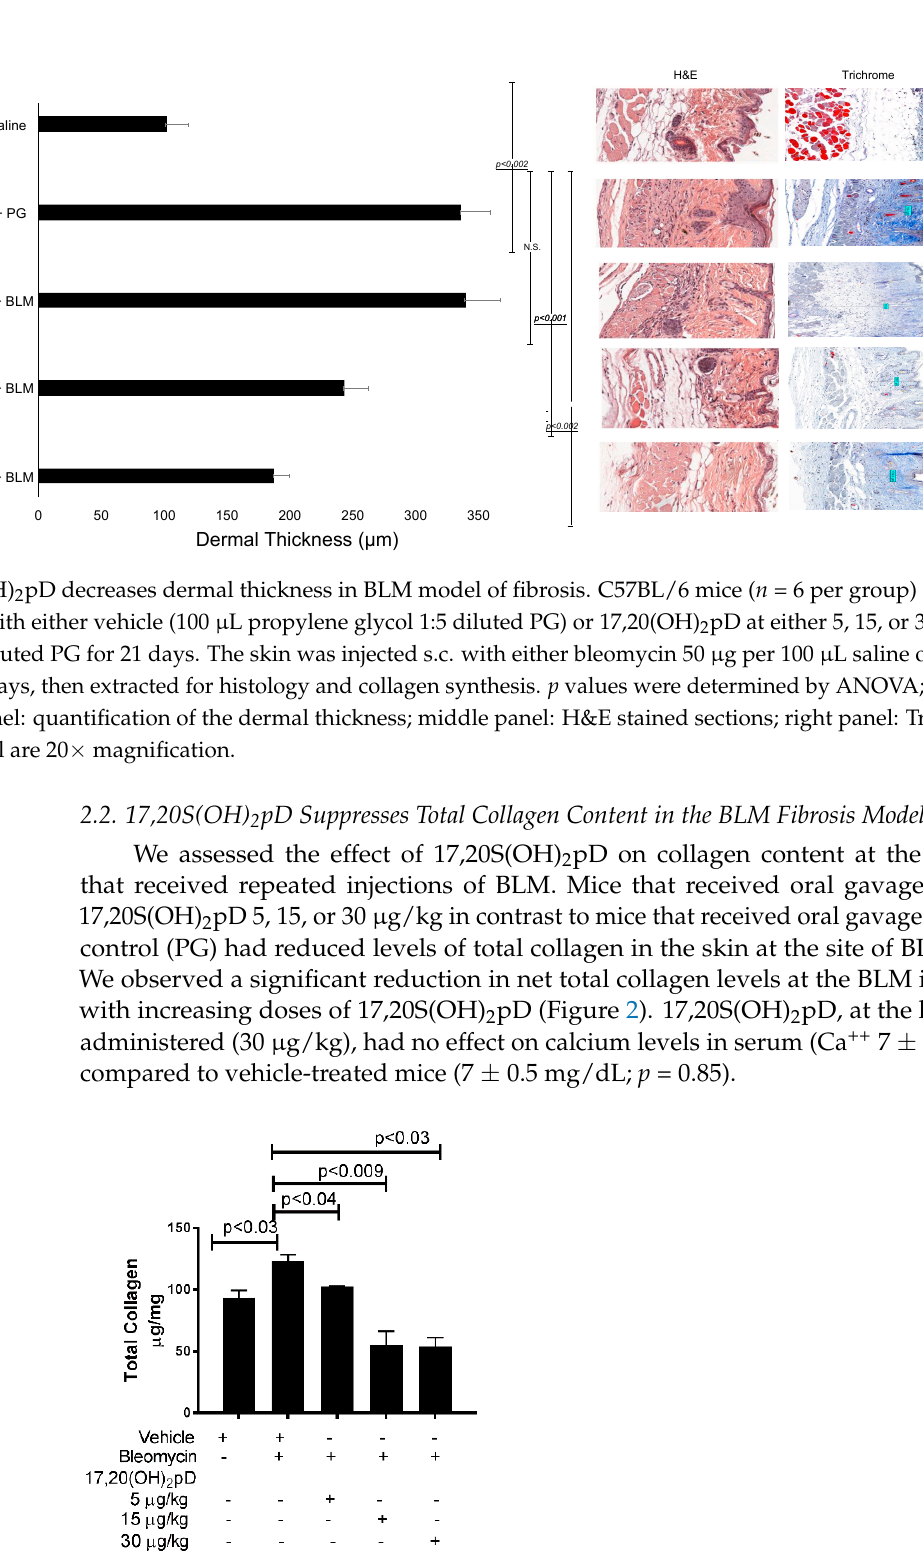
Figure 2. 17,20S(OH) 2 pD suppresses total collagen production in the BLM model of fibrosis. C57BL/6 mice (n = 6 per group) treated via gavage with either 17,20(OH) 2 pD at doses of 5, 15, and 30 µ g/kg or vehicle (propylene glycol) while simultaneously receiving s.c. injections of bleomycin for 21 days. Injected skin was analyzed for total collagen using Sircol collagen assay. Results are shown as mean ± SEM and p values were determined by ANOVA by comparing vehicle (PG) + BLM with those from PG + saline or 17,20(OH) 2 pD + BLM. + added to culture; - not added to culture.